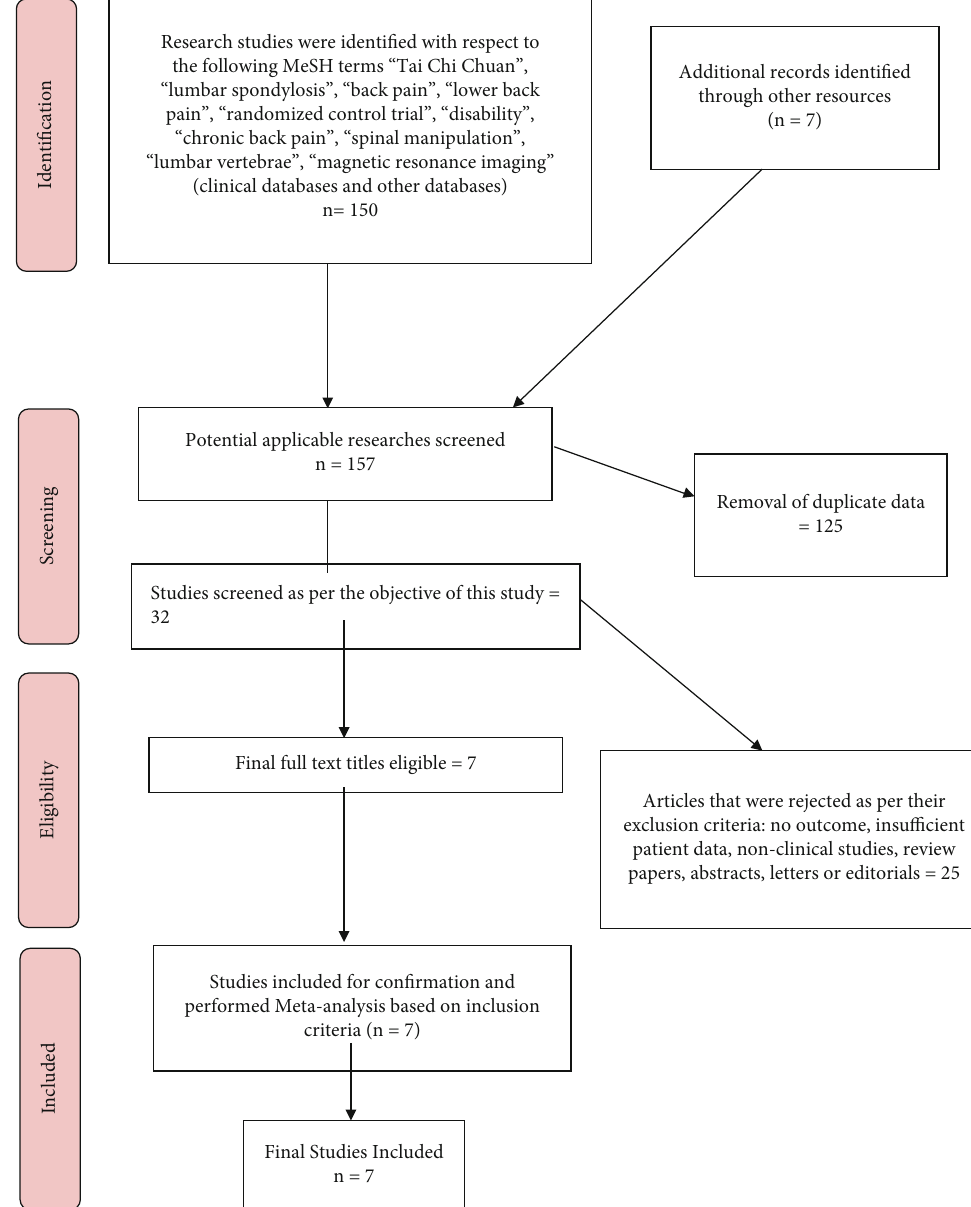
Figure 1: PRISMA study over the study